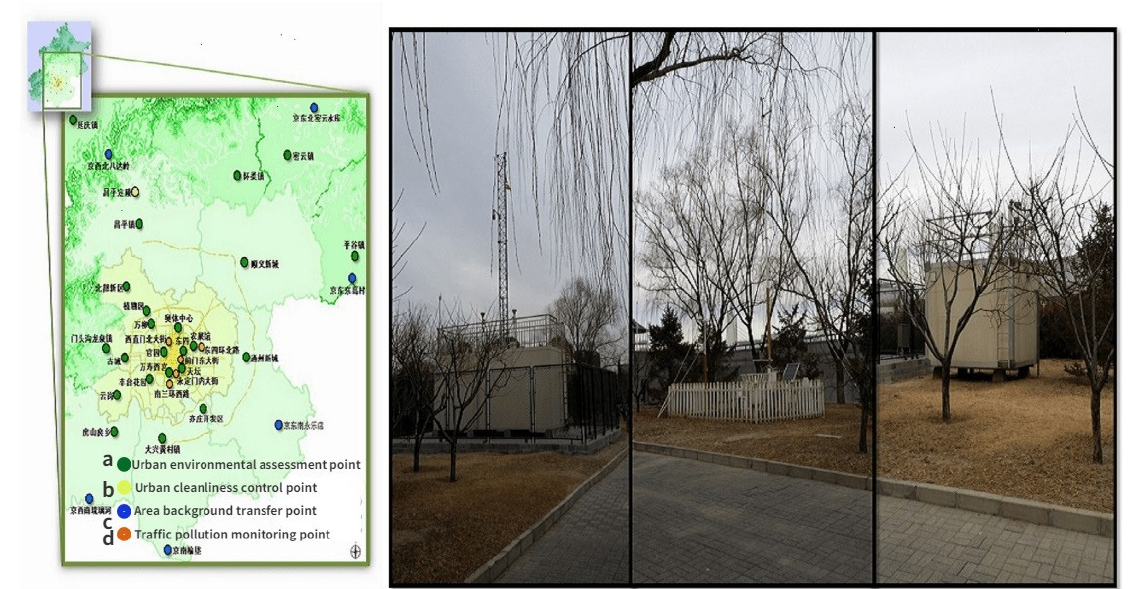
Figure 1. Location of monitoring sites of the Beijing Olympic Sports Center. Notes: The Chinese characters in the left picture is the meaning of Chinese Geographic Names, which also represents its geographical location. The green circle (a), yellow circle (b), blue circle (c), orange circle (d) in the left picture is the meaning of Urban environmental assessment point, Urban cleanliness control point, Area background transfer point, Traffic pollution monitoring point, respectively. And the number of this points are 23, 1, 6, 5, respectively.